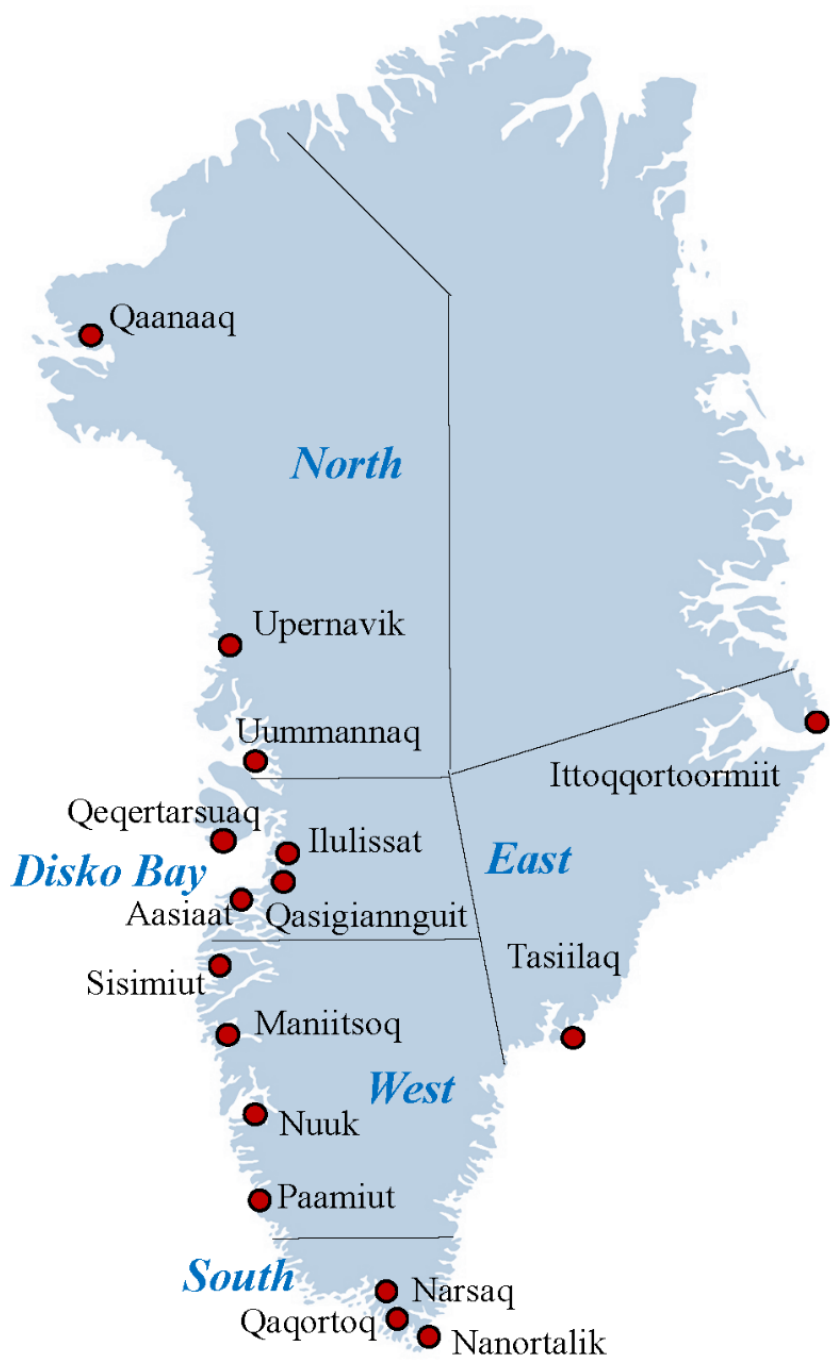
Figure 1. Map of Greenland with the data collection sites. Map source: Modified from colour- box.com.